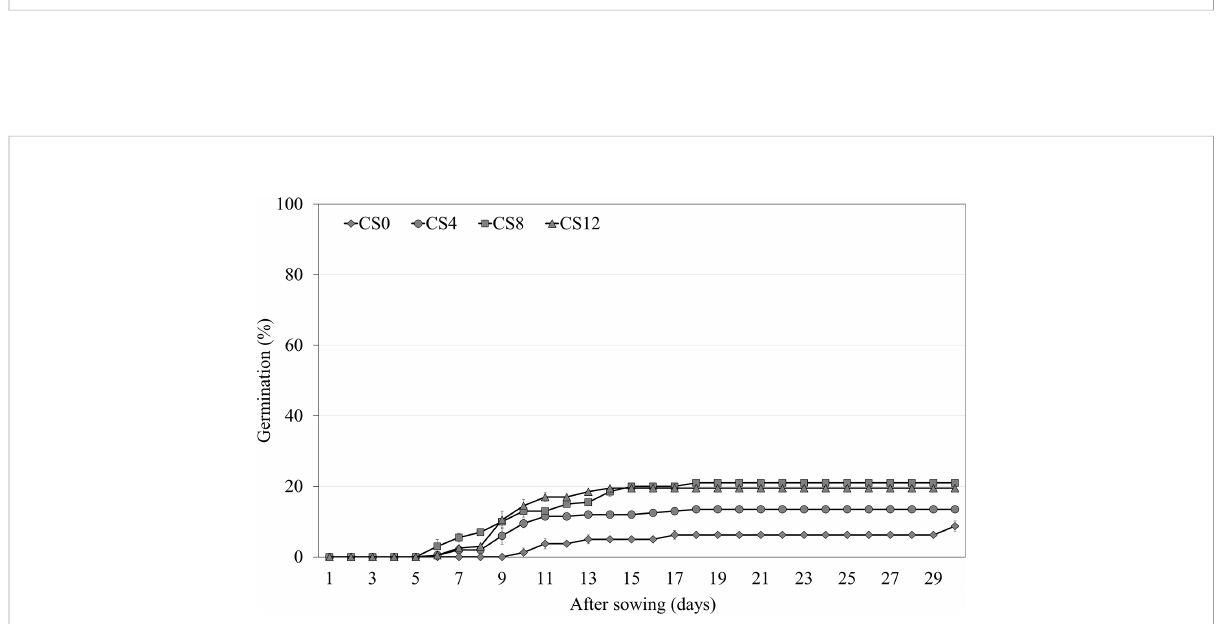
FIGURE 4 Germination of non-scari fi ed Amsonia elliptica seeds in light/dark at 25/15 °C after cold strati fi cation for 0 – 12 weeks. CS, cold strati fi cation (4°C). Bars represent standard error ( n = 4).